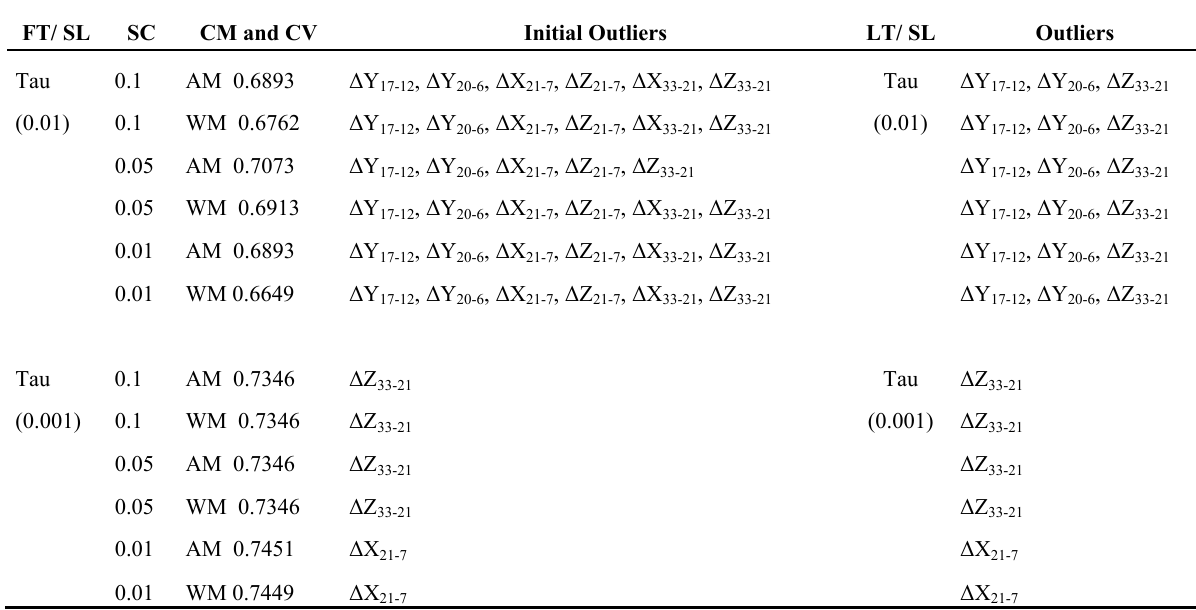
Table 6 . Results of the fuzzy logic method for the third GPS